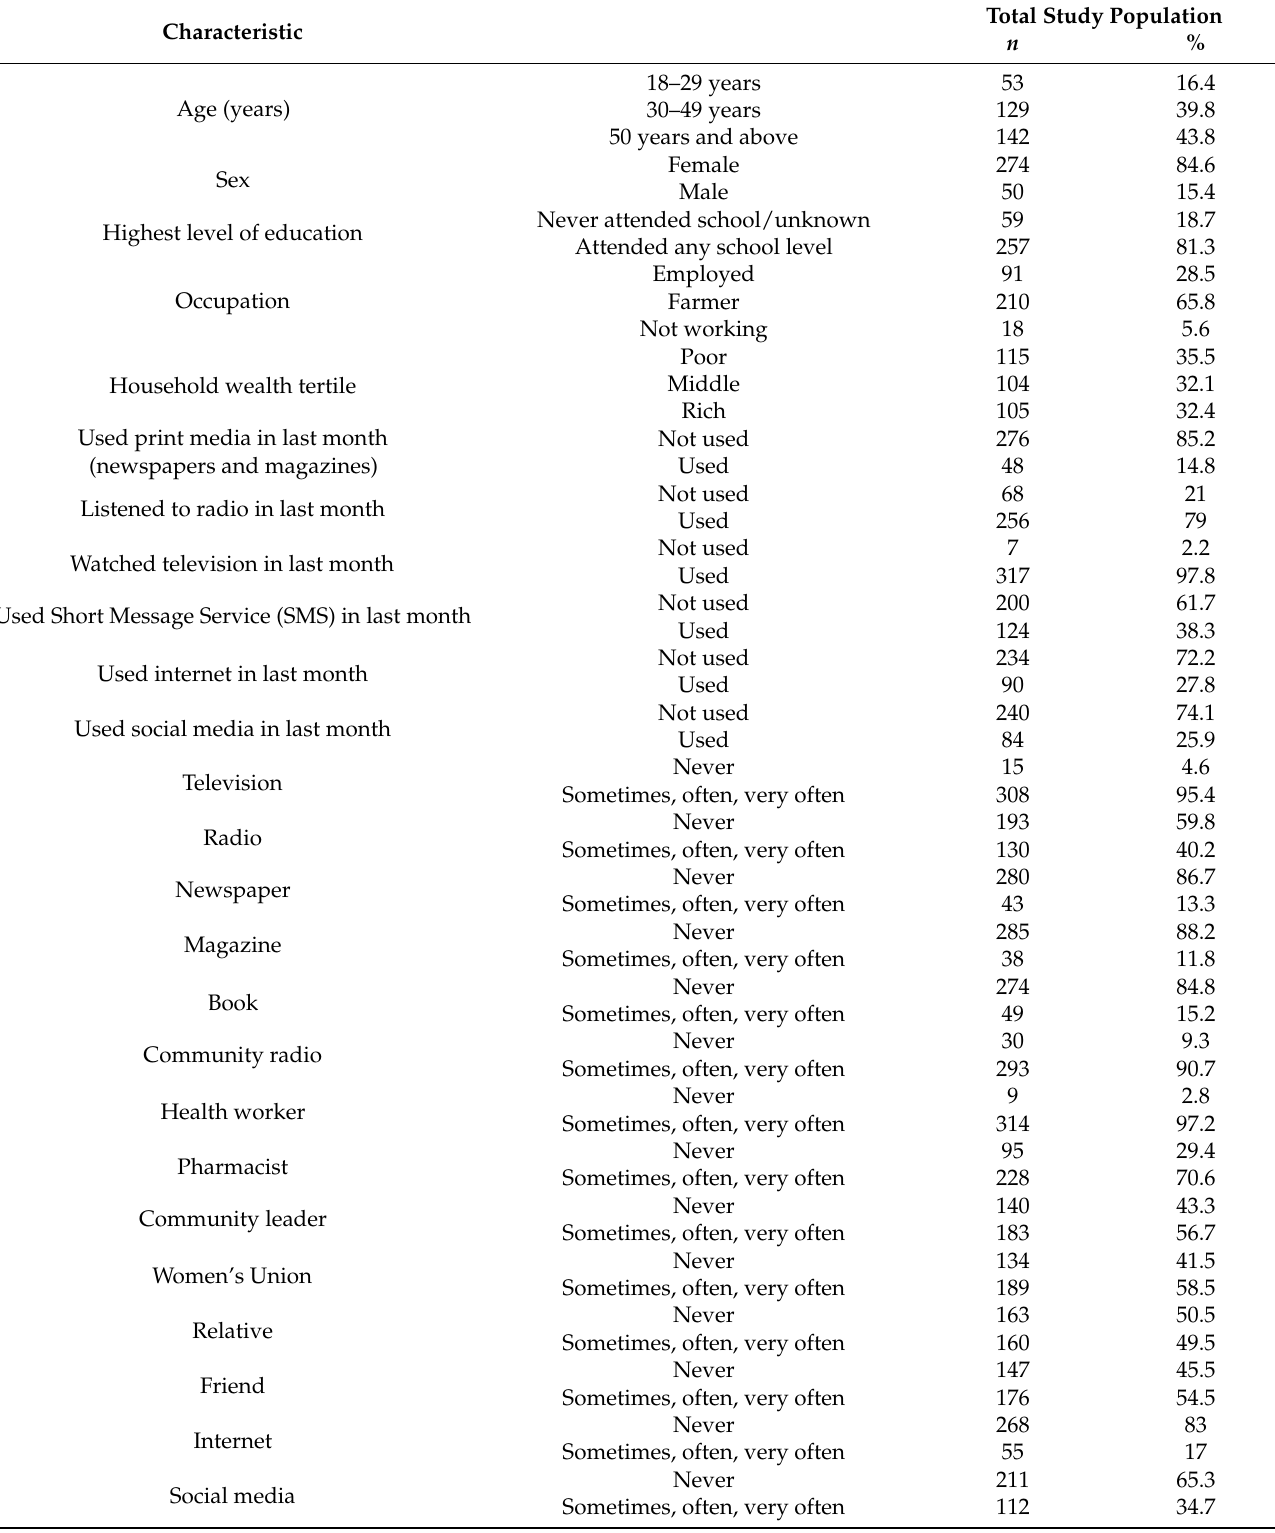
Table 1. Socio-demographics for the study